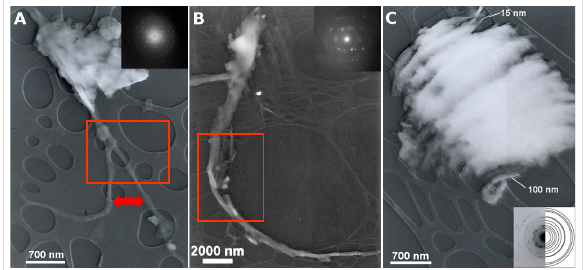
Figure 4: TEM images of symmetrical α , ω -nucleobase amide-conjug- ated systems: A – two splitting nucleoside nanofibres growing out from crystalline phase ( 11 ), the rectangular area ( A ) shows “twin fibres”; B – “twin fibres” growing out from microcrystalline “lizard tail” ( 11 ); C – nanofibres in bulky microcrystalline area ( 12